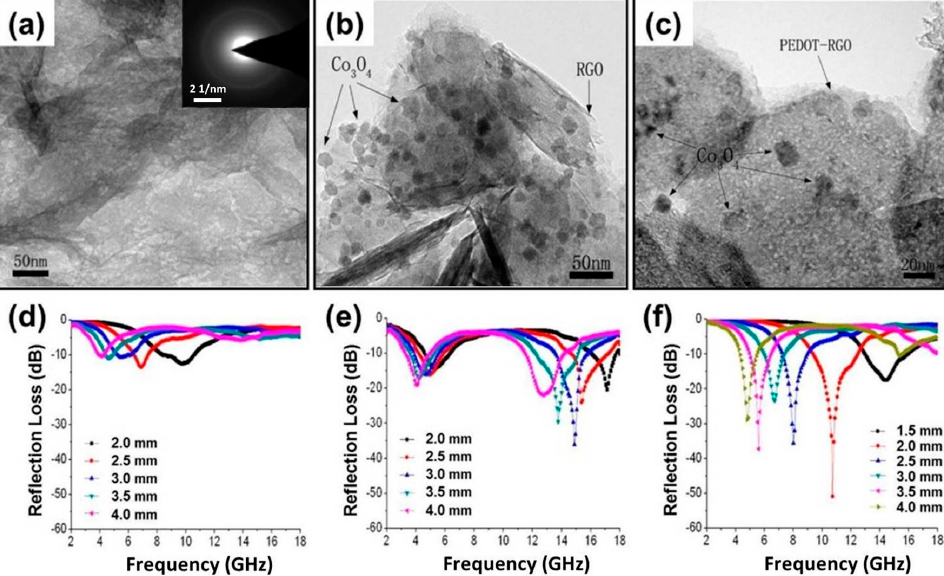
Figure 14. TEM image of ( a ) PEDOT–RGO (reduced graphene oxide); ( b ) RGO–Co 3 O 4 ; and ( c ) PEDOT-RGO-Co 3 O 4 . Reflection loss curves of ( d ) PEDOT–RGO; ( e ) RGO–Co 3 O 4 ; and ( f ) PEDOT– RGO–Co 3 O 4 . Reprinted with permission from Reference